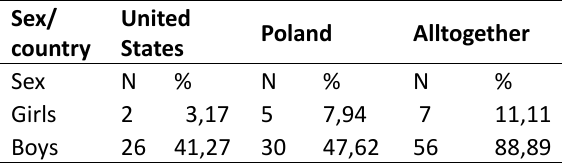
Table 1. Demographic characteristics of respondents by sex